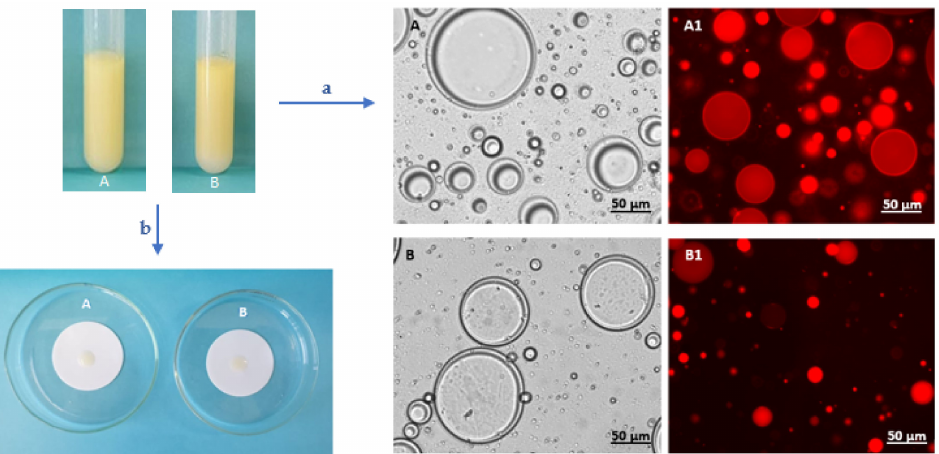
Figure 6. ( a ) Optical microscopic (40 × ) images of F1 ( A ) and F2 ( B ) emulsions; contrast phase and fluorescence after Nile Blue A staining ( A1 , B1 , respectively); ( b ) emulsion determination test by filter paper